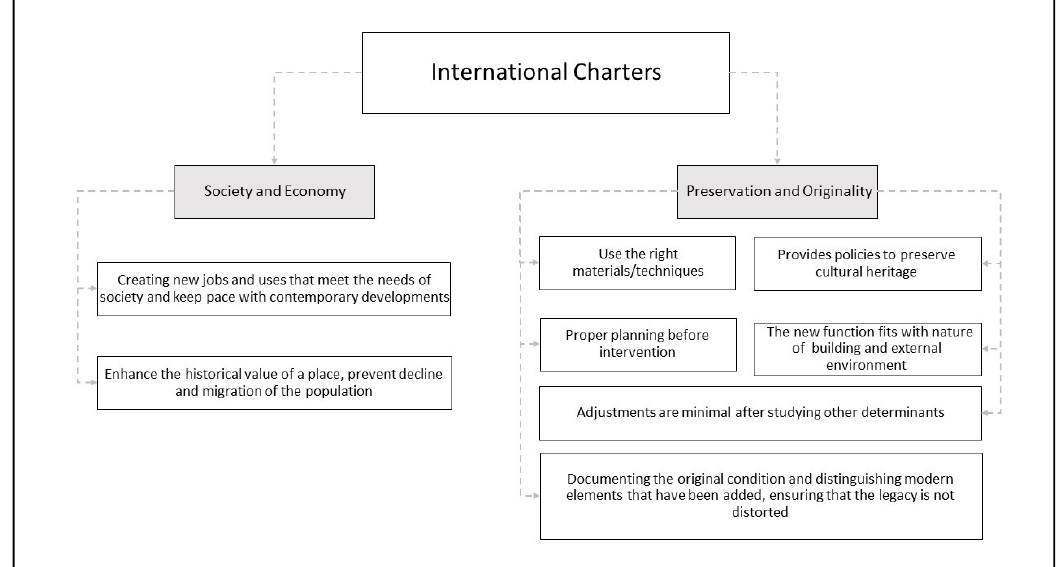
Figure 2. Summary of international charters .